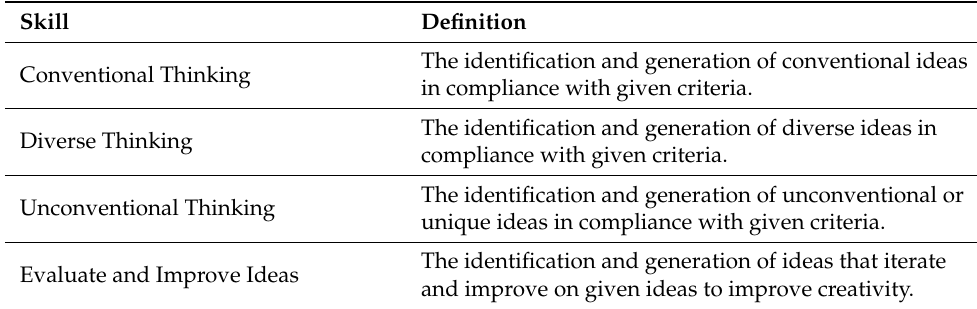
Table 1. Creative Thinking and Innovation Framework Skills and Definitions.